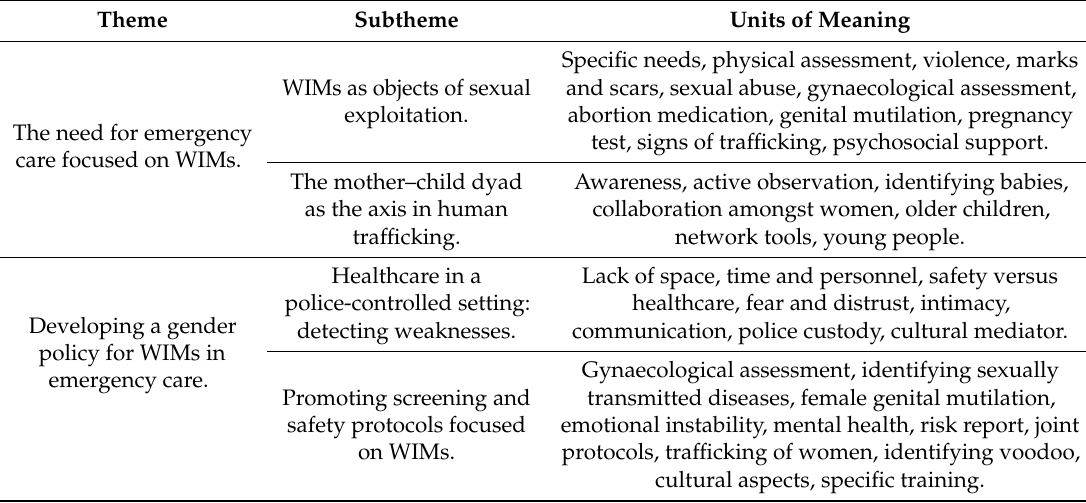
Table 3. Themes, sub-themes and units of